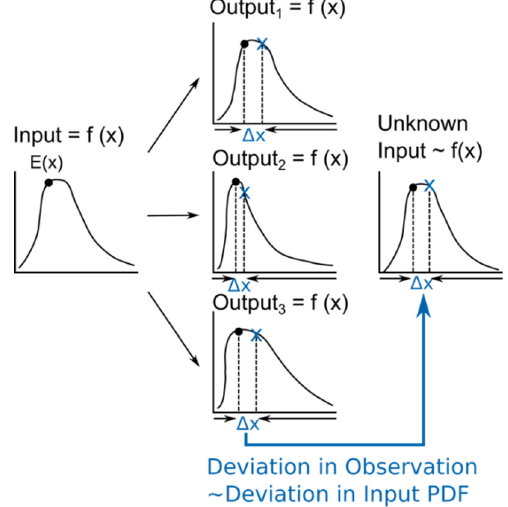
Figure 2. General principle of the cause-and-effect model, which receives the input PDF of an interference and provides the characteristics of the uncertainty induced by the interference for each position of the 4D trajectory in form of the output PDF. The model might be applied to a problem, by transferring the relative deviation Δx between observation and a reference point (e.g., the expected value E(X)) in the output PDF to the relative deviation of an assumed PDF of an unknown variable.